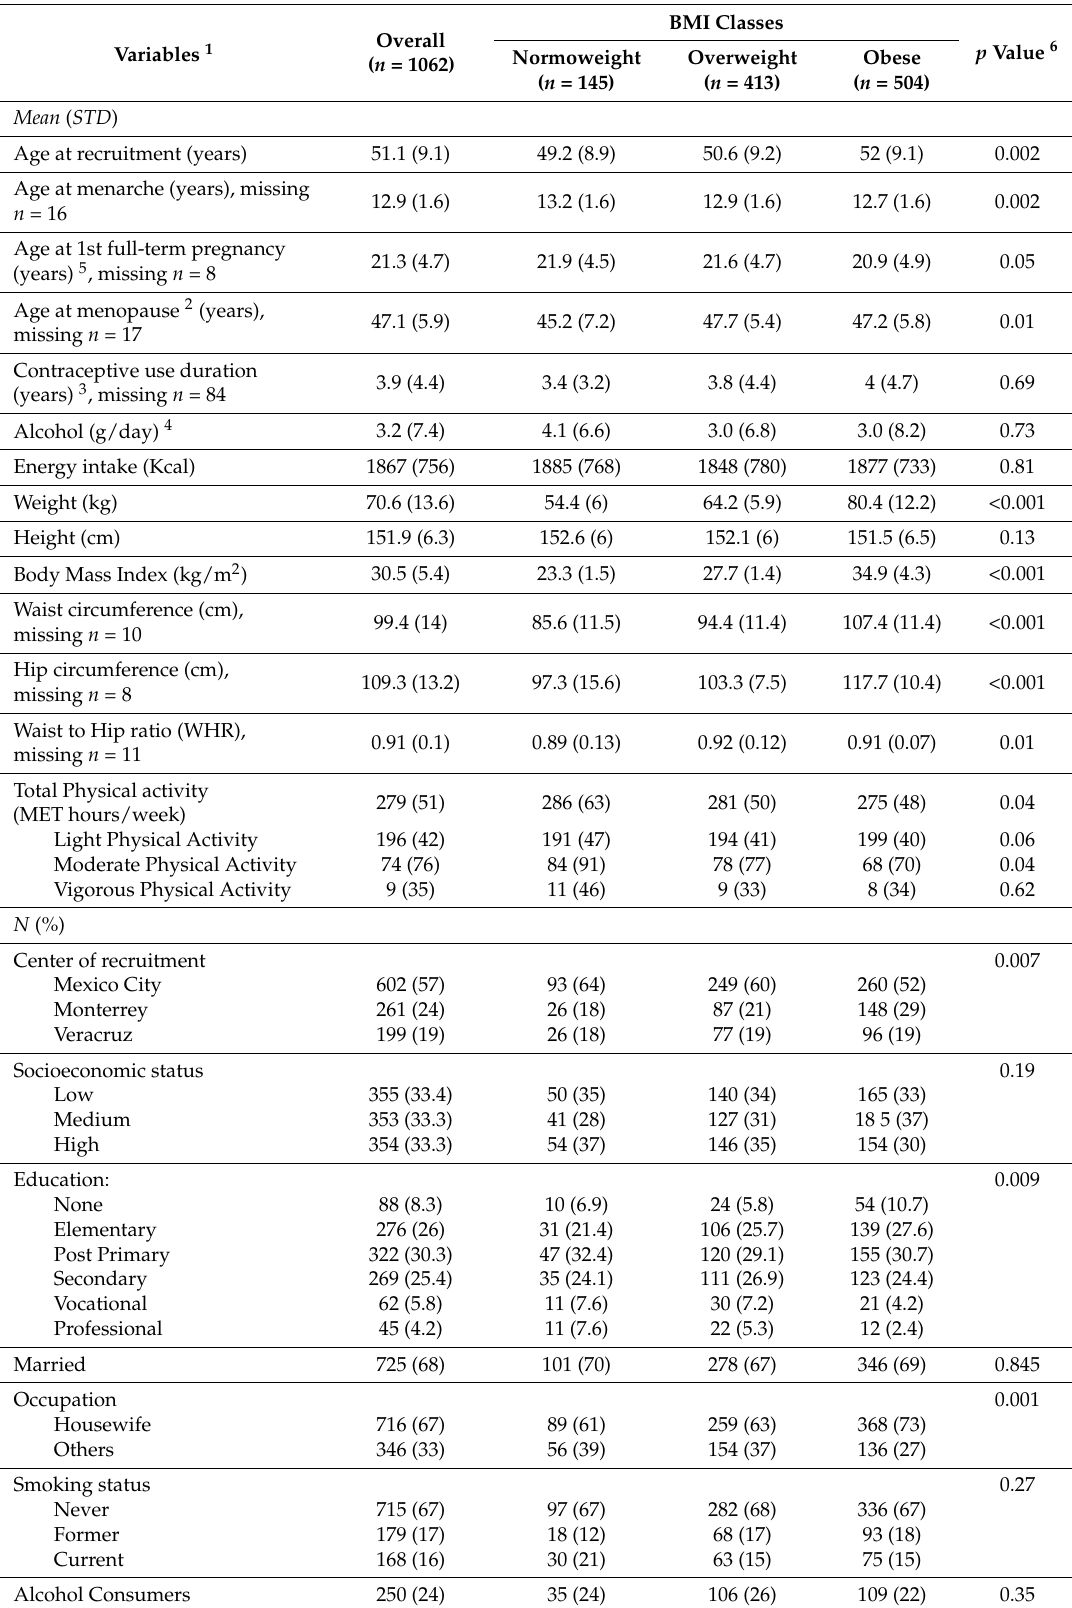
Table 2. Baseline characteristics of the study population according to body mass index ( n =